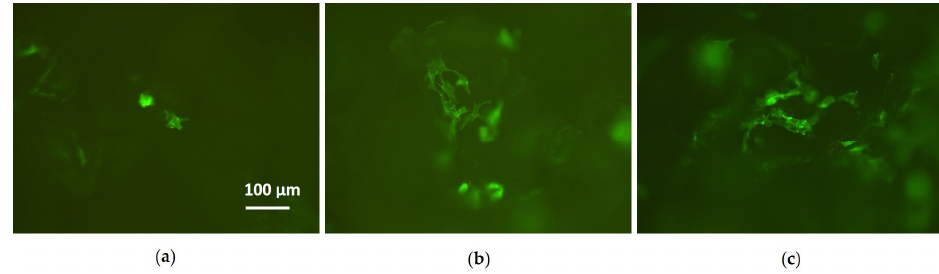
Figure 10. Fluorescence microscopy images of Saos-2 cells (88 h) on sections of ( a ) control, ( b ) H 2 O/Mg2.5/absorbent, and ( c ) H 2 /Mg15.8 scaffolds. Atto488 phalloidin was used to observe the actin